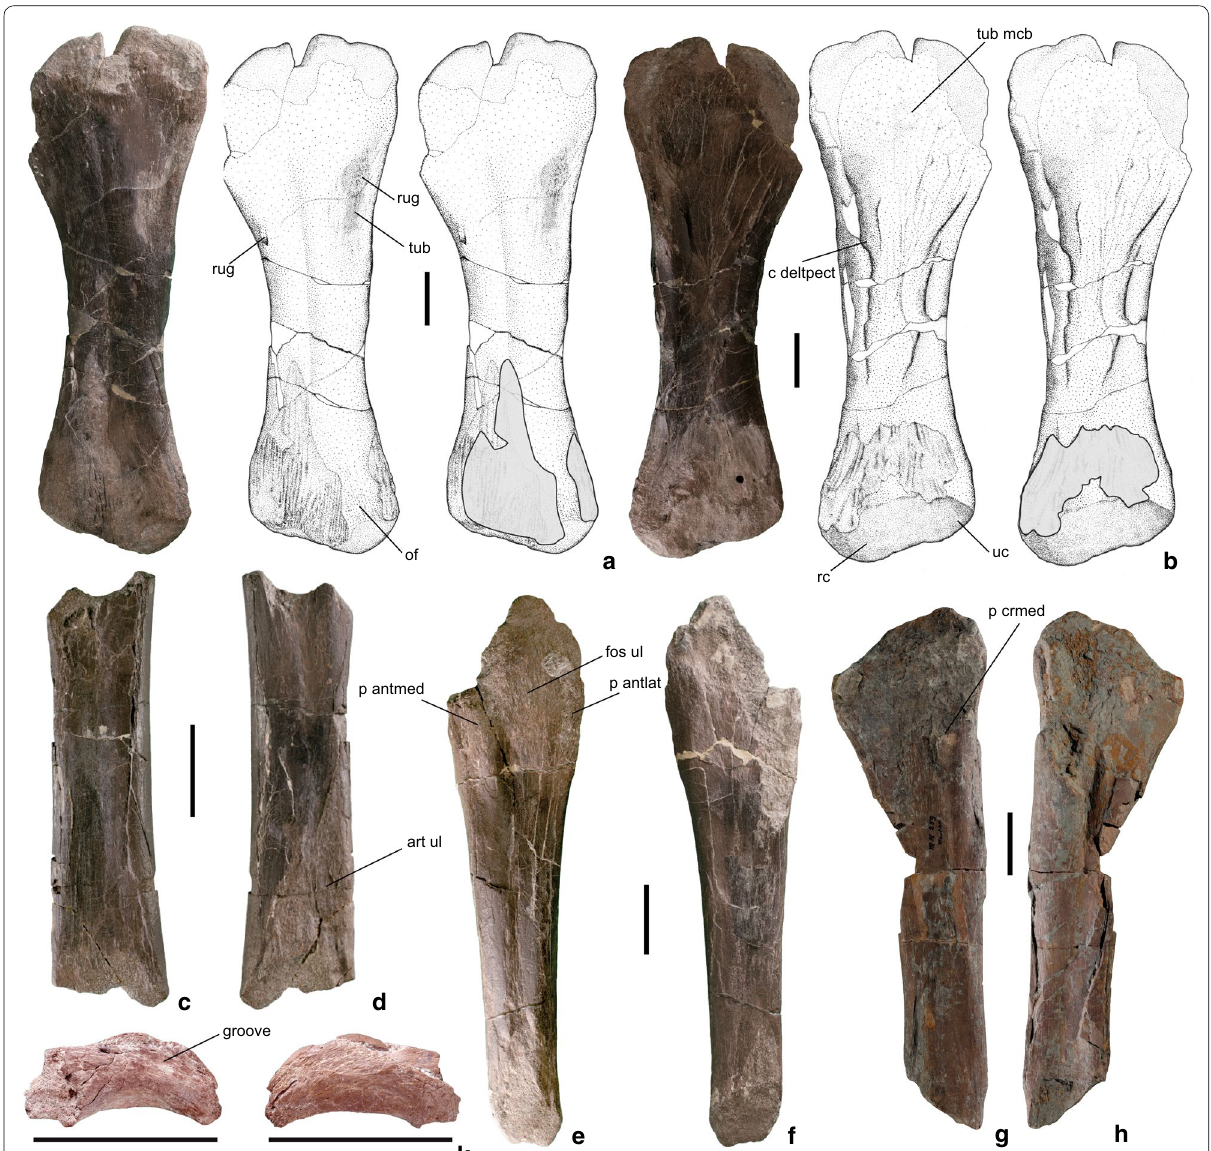
Fig. 10 Forelimb of A. greppini . Right humerus NMB M.H. 260 with preservation of distal articular cartilage, a posterior and b anterior aspect, from left to right: photograph, interpretative drawing and drawing with preserved articular cartilage highlighted in grey. Left radius NMB M.H. 264 of A. greppini , c in anterior and d in posterior aspect. Left ulna NMB M.H. 340 of A. greppini in e anterior and f posterior aspect. Right ulna NMB M.H. 259 g in anterior and h in posterior aspect. Manual ungual phalanx NMB M.H 269 in i medial and k lateral aspect. Scale bar is 50 mm. Drawings by Serafin Padzera. art ul articulation surface of ulna at radius, c deltpect deltopectoral crest, fos ul ulnar fossa, p antlat craniolateral process, p